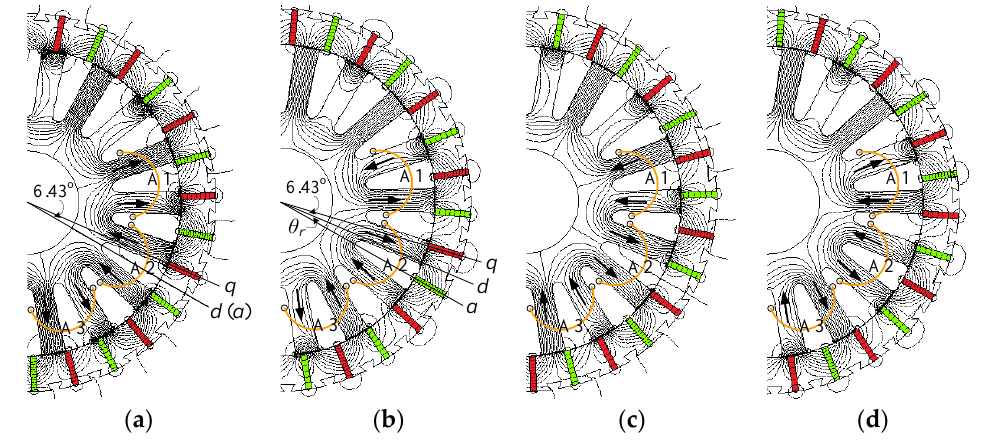
Figure 2. Open-circuit field distributions of the proposed 18-slot/8-pole FMPM machine at four different rotor positions, θ e (“ ” represents the direction of flux line). ( a ) θ e = 0°; ( b ) θ e = 90°; ( c ) θ e = 180°; and ( d ) θ e = 270°.